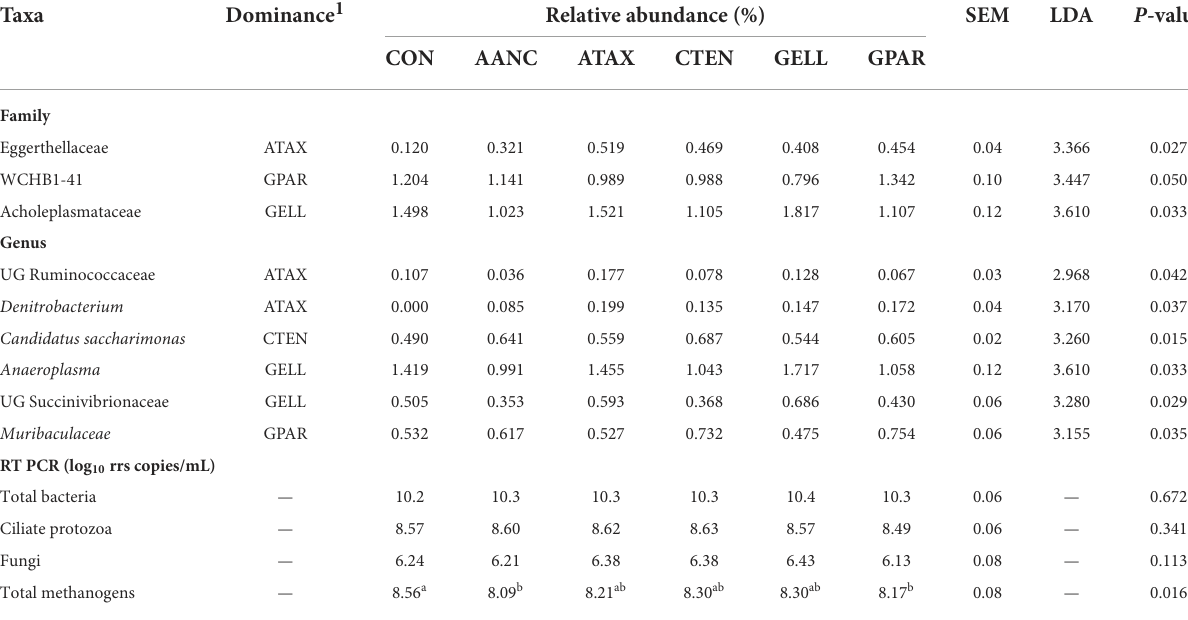
TABLE 4 Abundance of bacteria families and genera in response to supplementation with red seaweed extracts evaluated with LEfSe analysis after 24h of in vitro incubation.